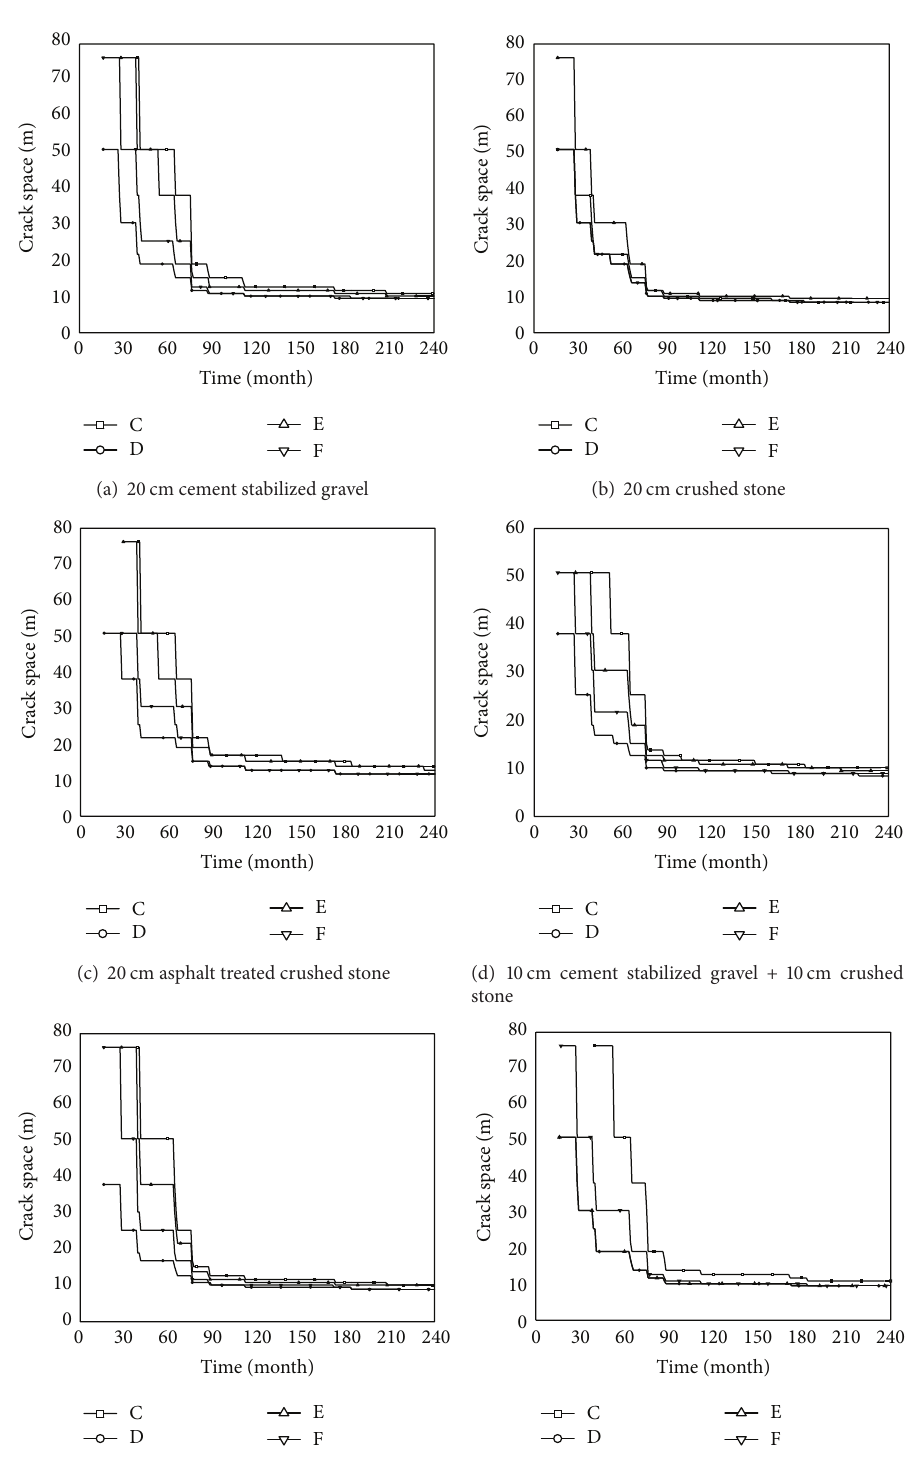
Figure 9: Thermal cracking development of asphalt pavements with different base combinations. Note: the terms “C,” “D,” “E,” and “F” were defined in Table